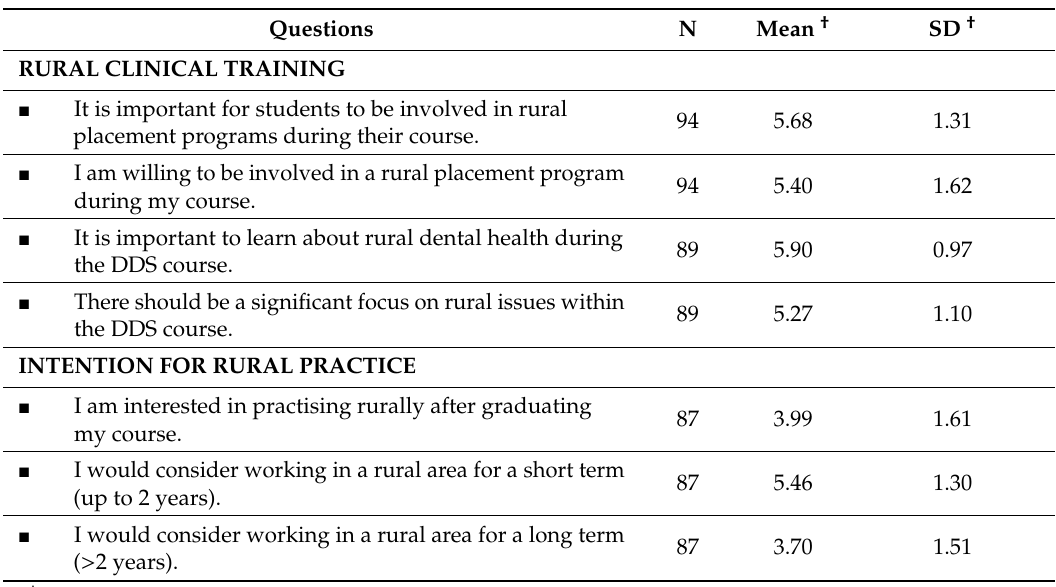
Table 6. Opinion of first-year dental students about the relevance of rural clinical training and their intention to work in rural areas after graduation. Questions N Mean † SD †